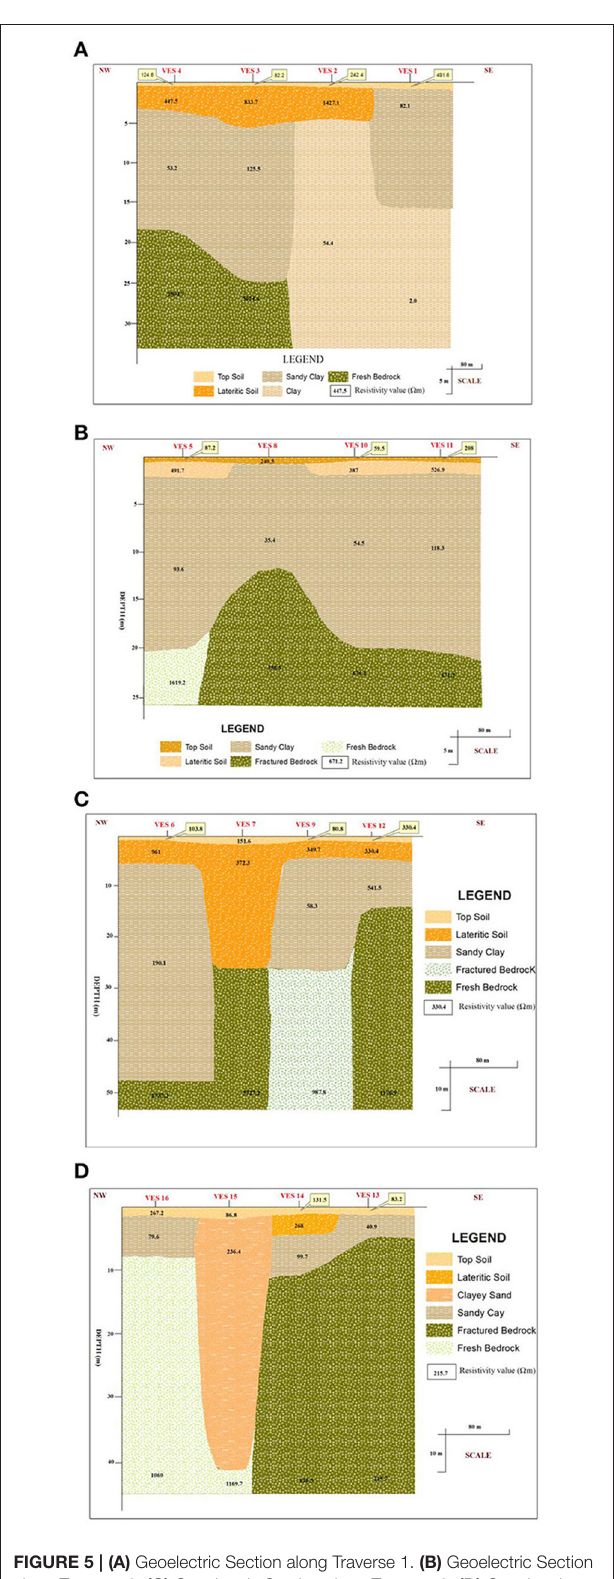
FIGURE 5 | (A) Geoelectric Section along Traverse 1. (B) Geoelectric Section along Traverse 2. (C) Geoelectric Section along Traverse 3. (D) Geoelectric Section along Traverse 4.